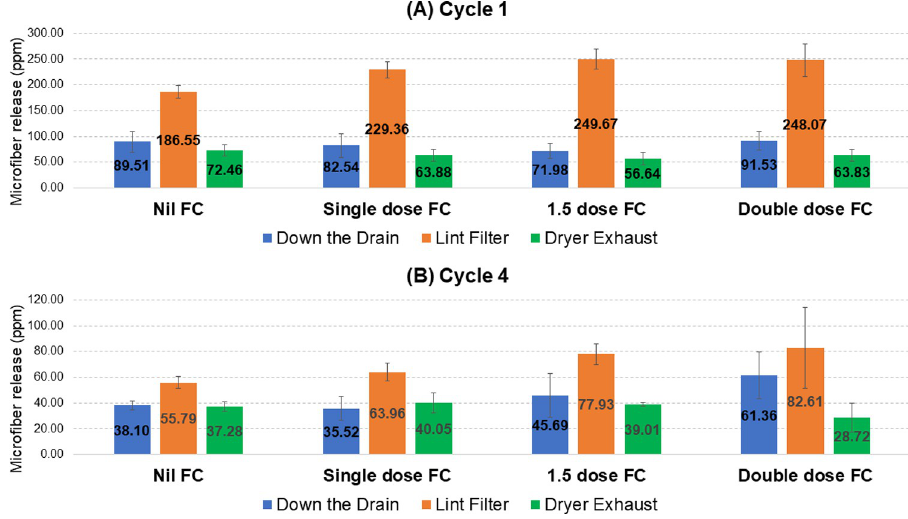
Fig 4. Microfiber release from the first and fourth cycles: North America liquid fabric conditioner testing. Microfiber release during the first ( A ) and fourth ( B ) cycles at each of the three measurement points for all four levels of fabric conditioner (FC) is given in ppm (mg release per kg fabric). Error bars are the standard deviation.